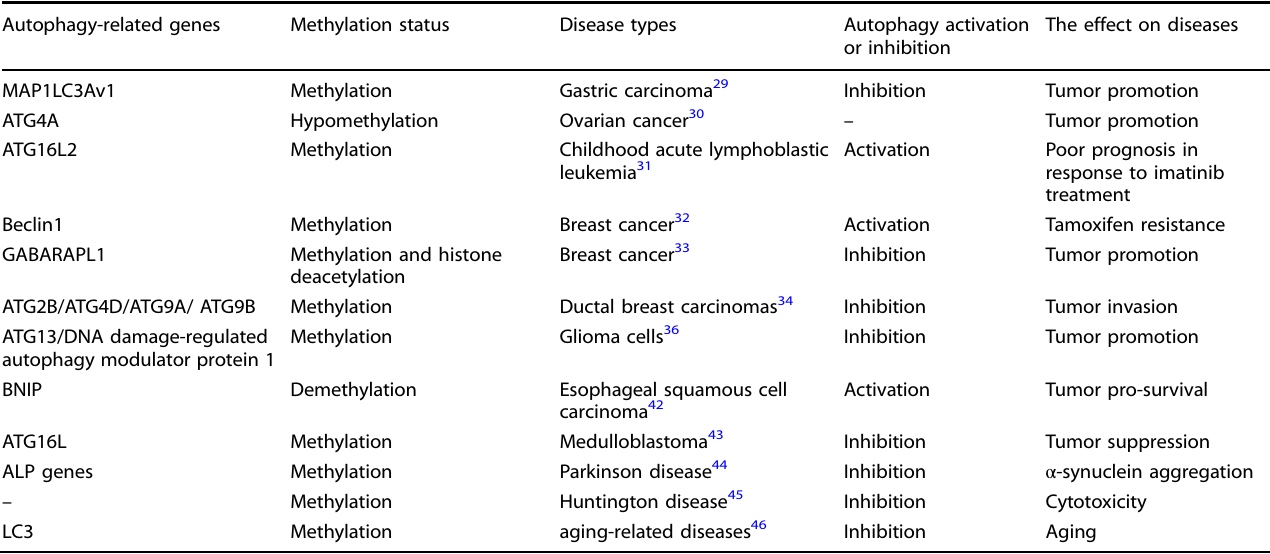
Table 1. DNA methylation of autophagy-related genes in diseases Autophagy-related